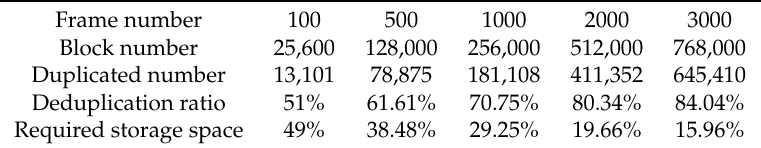
Table 1. Deduplication ratio for the video using the duplicate removal storage system.